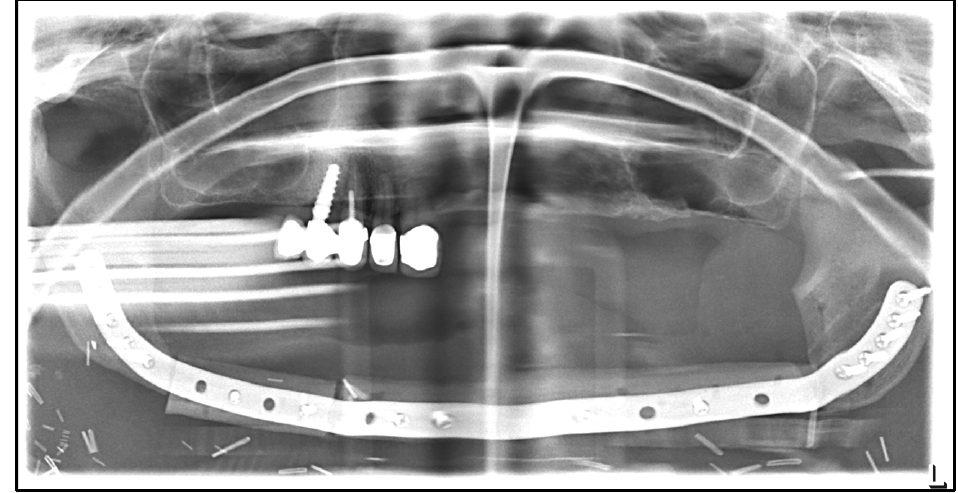
Figure 7. Dental X-ray after mandibular resection and primary bony reconstruction using a free fibular flap, April 2020.